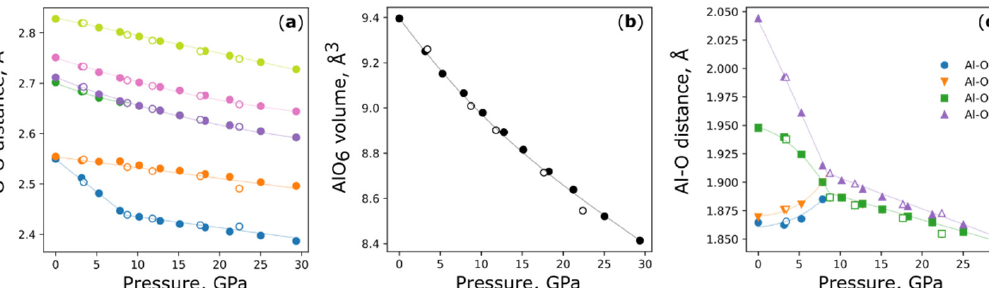
Figure 5. Variation of relative lattice parameters of δ -AlOOH with pressure. Lines are guides to the eye and error bars are smaller than the marker sizes.